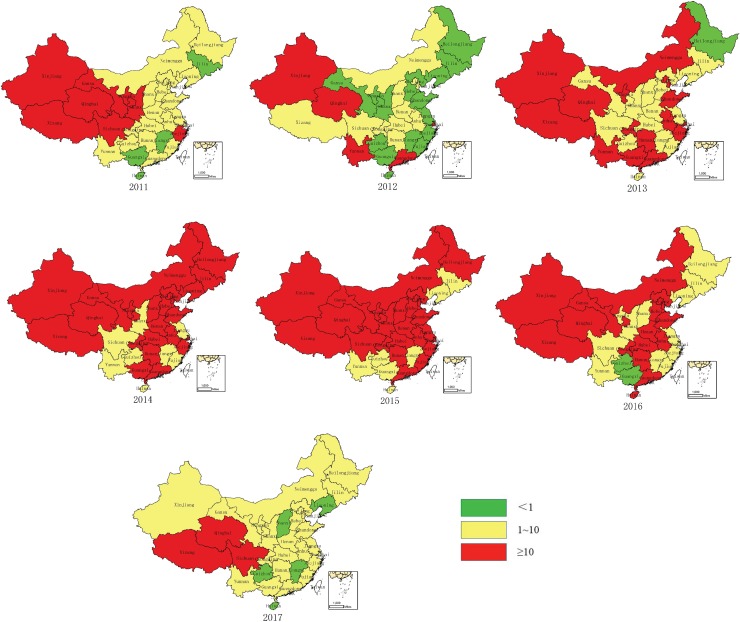
Measles incidence in China 2011–2017 by province.Source: NNDRS.